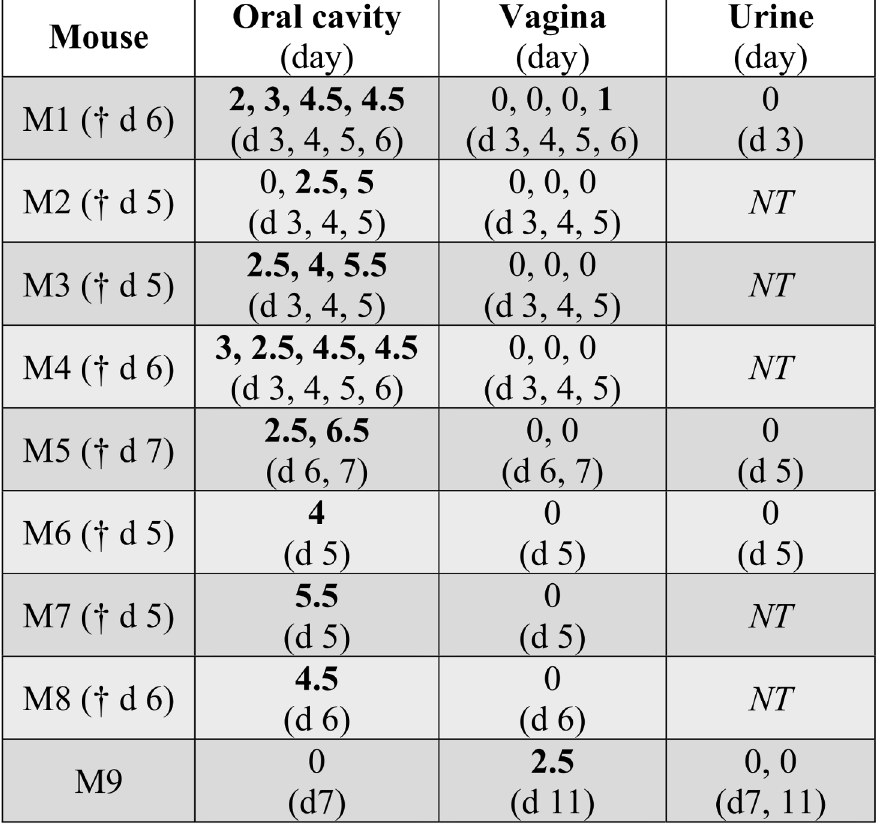
Fig 2. Virus in oral cavity washings, vaginal washings and urine of CHIKV-infected IRF3/7 -/- mice. Mice were infected with CHIKV i.p. (n = 9) and when clinical symptoms of hypovolemic shock became apparent (indicating onset of hemorrhagic manifestations) [6], mouth washings (Oral cavity), vaginal washings (Vagina) and urine (where possible), were collected and viral titers determined and expressed as log 10 CCID 50 /ml of washing medium on the indicated day (which is indicated in brackets below the titer Figs, respectively). † day when mouse was euthanized. NT – not